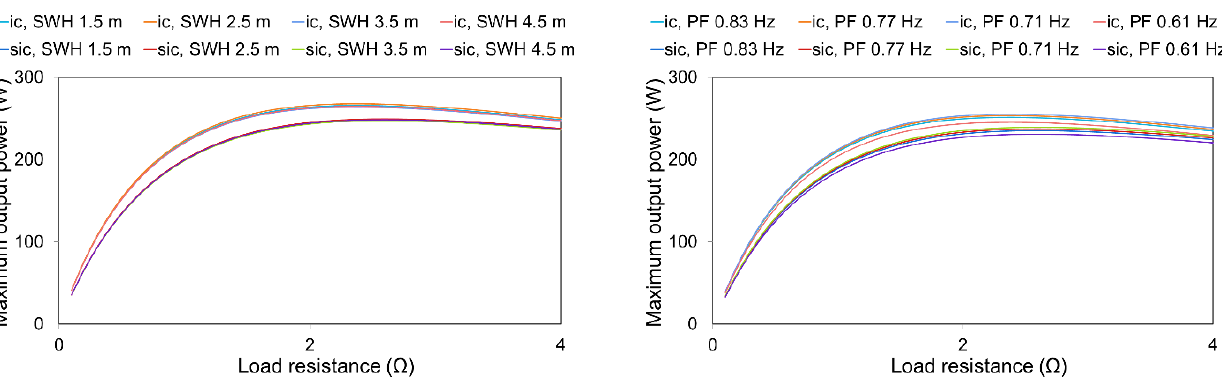
Figure 24. Maximum output power resulted from different LPMG designs under different random wave parameters and load resistances (ic: iron-cored, sic: semi iron-cored, SWH: significant wave height, PF: peak frequency). Table 7. The effective and maximum output power of the LPMG designs under random wave variations.